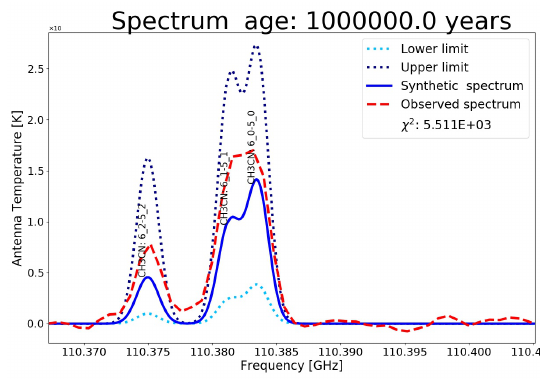
Figure 1. Example of multiple lines blending